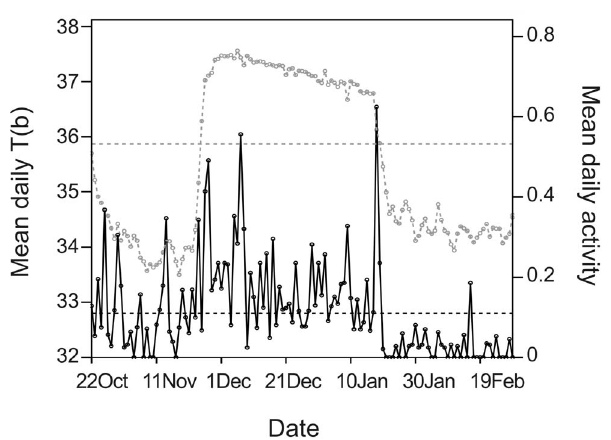
Figure 4. Example of the mean daily activity and mean daily body temperature (T(b)) recordings for a hibernating pregnant female brown bear in Sweden. The horizontal gray and the black dotted lines show the mean individual body temperature and activity during hibernation, respectively, which were used to calculate the dates of implantation and parturition.